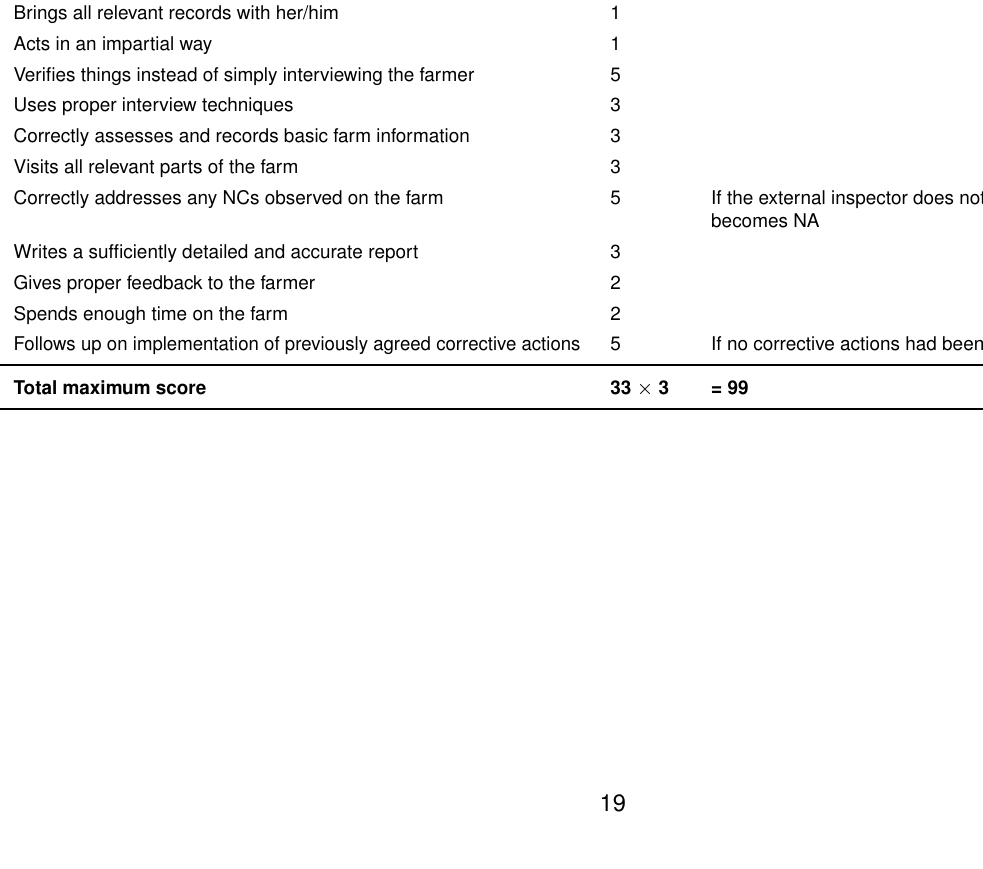
Table 6. Scoring tool using a Likert scale for witness audits with internal inspectors. For each criterion, the external inspector can make a choice: “Strongly agree / Agree / Disagree / Strongly disagree”, corresponding to 3, 2, 1 and 0 marks, respectively. The results are weighted for calculating the sum, because not all criteria are equally important. Subject: The internal